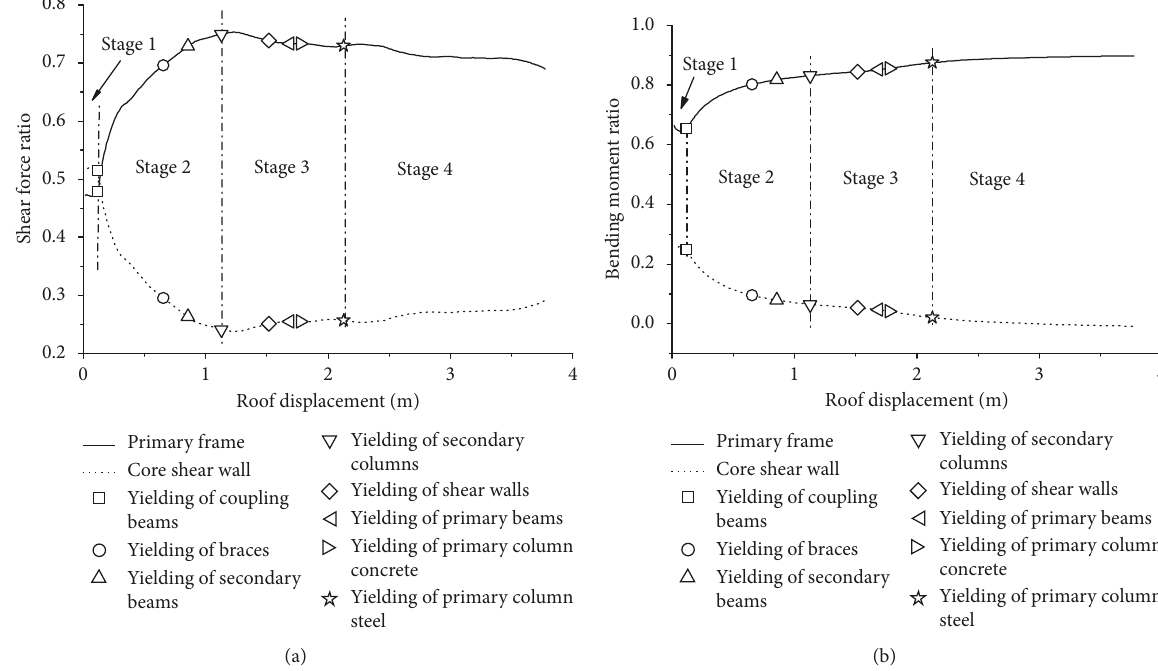
Figure 13: Internal force coefficient of model 5MBC: (a) shear force ratio; (b) bending moment ratio.